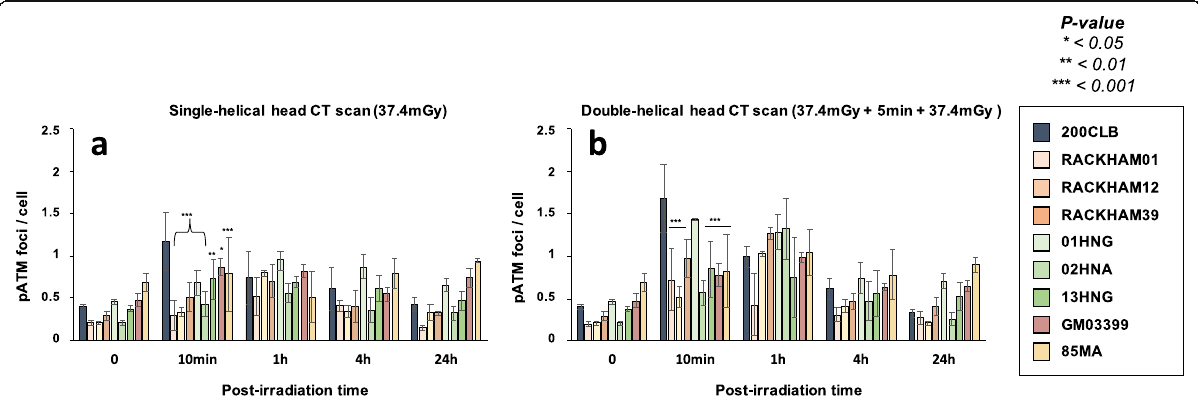
Fig. 5 pATM foci in fibroblasts after single- and double-helical CT scan exposure. a Kinetics of pATM foci in fibroblasts after a single-helical head CT scan, or ( b ) a double-helical head CT scan at the indicated times after exposure (t0 = non-irradiated). Each data represents the mean ± SEM of 3 independent experiments. The asterisks shown at 10 min post-irradiation times correspond to a statistically significant difference between the cell line and the radioresistant 200CLB controls. CT Computed tomography, γ H2AX Phosphorylated forms of the H2AX histone variant, pATM Phosphorylated forms of the ATM protein, SEM Standard error of the mean